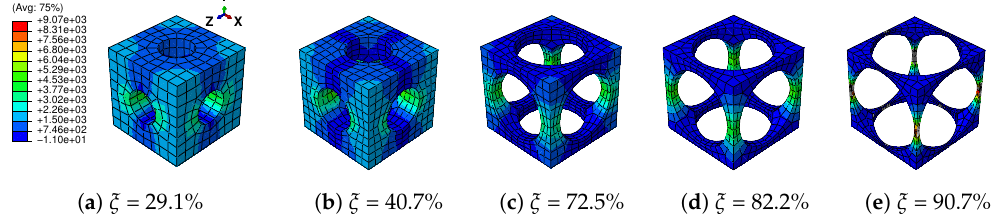
Figure 6. Distribution of stress in Y direction (S22) on the RVEs with different void volume fractions ξ in tension loading at strain level 10%.